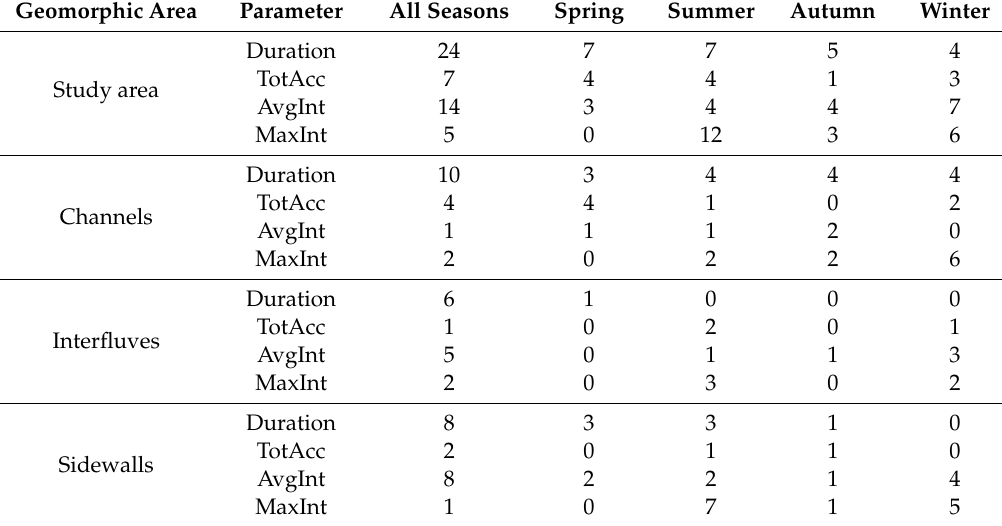
Table 6. Retention frequency of lagged precipitation parameters (Duration, Total Accumulation (TotAcc), and Average and Maximum Intensity (AvgInt and MaxInt, respectively) in OLS regression models of erosion annually and seasonally for the full study area and for each geomorphic area: Channels, Interfluves, and